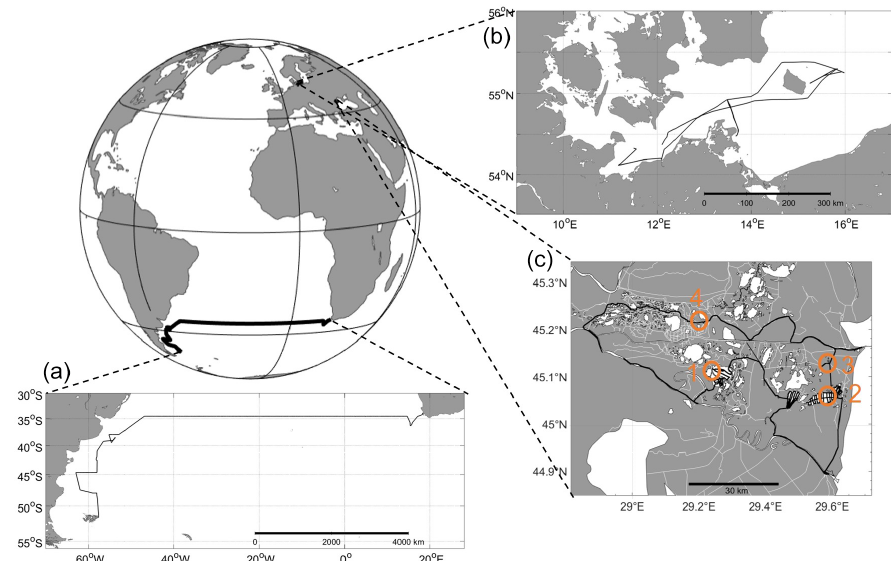
Figure 3. Transects for all test sites. (a) Oceanic – South Atlantic; RV Meteor , cruise M133; ocean (Cape Town, South Africa, to Stanley, Islas Malvinas). (b) Brackish – RV Elisabeth Mann Borgese , cruise EMB 142; western Baltic Sea. (c) Limnic – Rom1–3; Danube Delta, Romania. Orange circles, labelled 1 through 4, show the stations of stationary overnight stops (see Fig. 11). For further information,